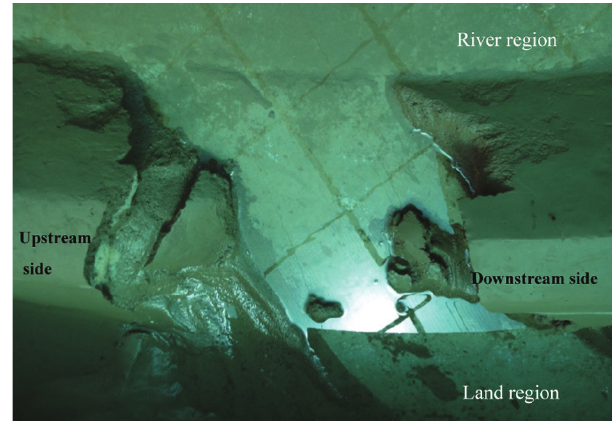
Figure 9. Final breach form.